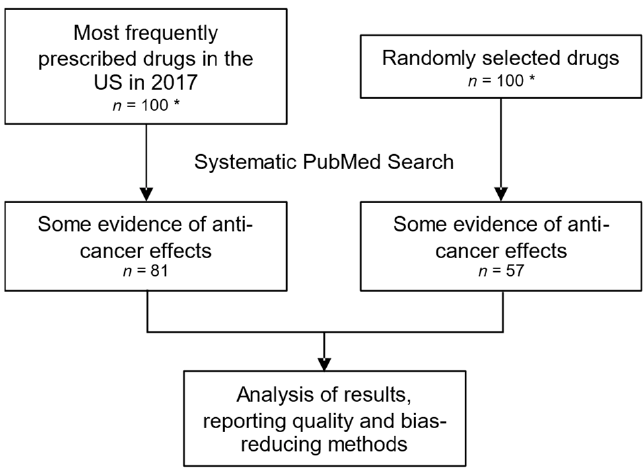
Figure 2. Flowchart of drug selection and subsequent analyses. * All drugs that could be classified as a non-small molecule, mineral, vitamin or endogenous hormone, and all drugs that were already approved for any cancer entity, were excluded.